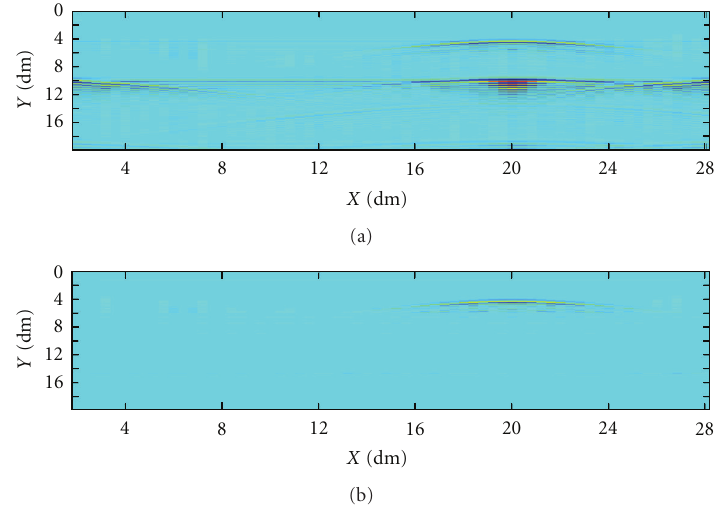
Figure 6: The case of Figure 5. (a) Radargramm after average trace subtraction, (b) windowed radargramm.